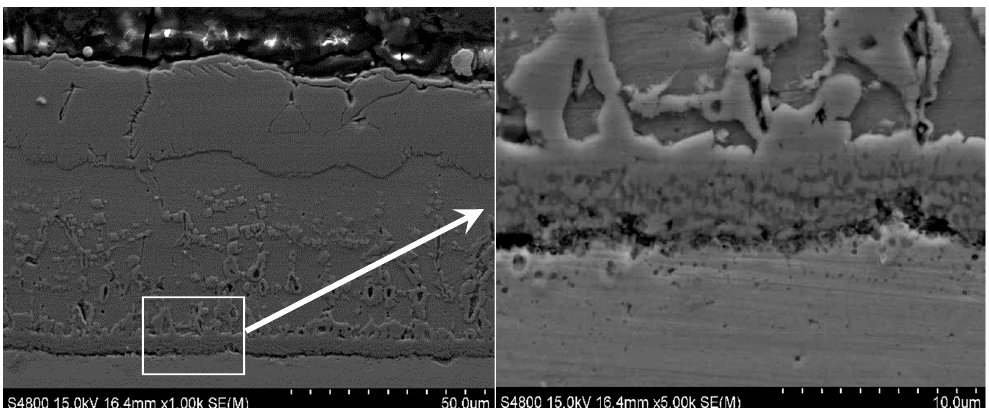
Figure 10. Cross-sectional image of the oxide scale obtained at 1100 °C.